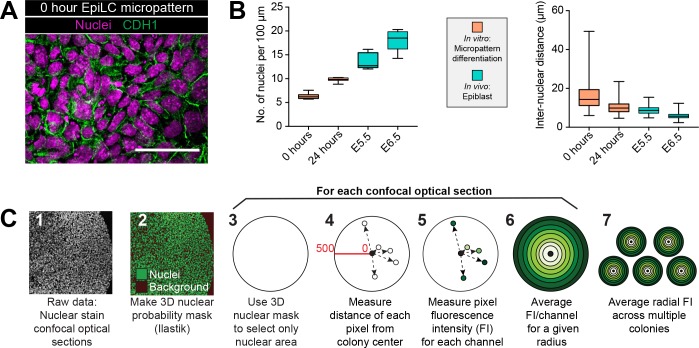
Micropatterned EpiLC colonies begin as an epithelial monolayer that increases density over time.(A) Confocal optical section of a region of an immunostained EpiLC micropatterned colony at 0 hr. Scale bar, 50 μm. (B) Quantification of nuclei/100 μm and distance between nuclei (in μm) in vitro after 0 hr and 24 hr of micropattern differentiation and in vivo at embryonic day (E) 5.5 and 6.5. For nuclei/100 μm, the number of nuclei across the width of a micropatterned colony at 10 different positions was quantified. In vivo quantification was carried out on sections of 5 different embryos at E5.5 and 6.5. For quantification of inter-nuclear distance, 0 and 24 hr of micropattern differentiation: n = 150, E5.5: n = 128 (5 embryos), E6.5: n = 189. Quantification details can be found in the Materials and methods section. (C) Schematic diagram of quantification of radial fluorescence intensity of immunostaining on micropatterns.